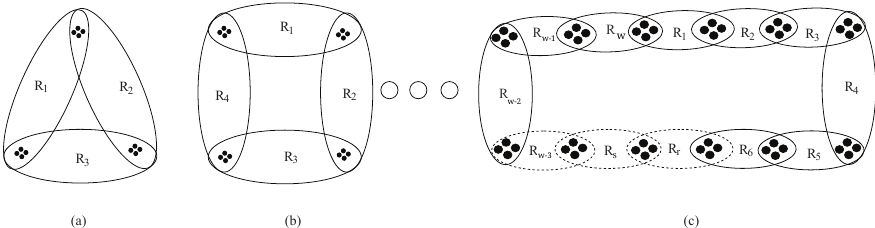
Figure 3. Cyclic order of intersection of Resolving Neighbourhoods with ( a ) three RNS, ( b ) Four RNS and ( c ) w